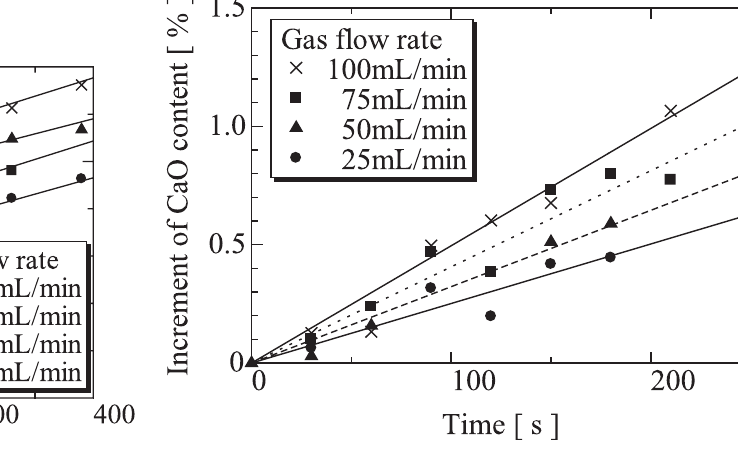
of p-Lime is dissolved into 100 g of FeO-CaO-SiO slag. The 2 increment of CaO content is increased with time while the rate is increased with the gas flowrate. There is not so much difference between the dissolution rate of s-Lime and the p-Lime, though the porosity is different. Figure 8